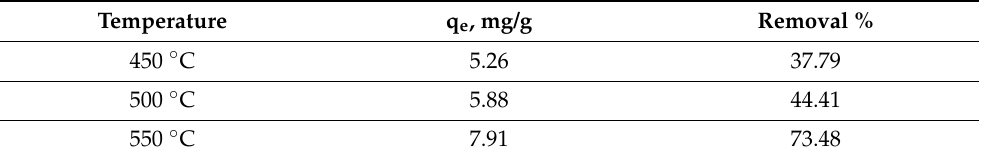
Table 6. Results of the lead adsorption tests in aqueous solution. Initial lead concentration = 10 mg/L; volume of solution = 50 mL; amount of solid = 0.05 g; contact time = 120 min; room